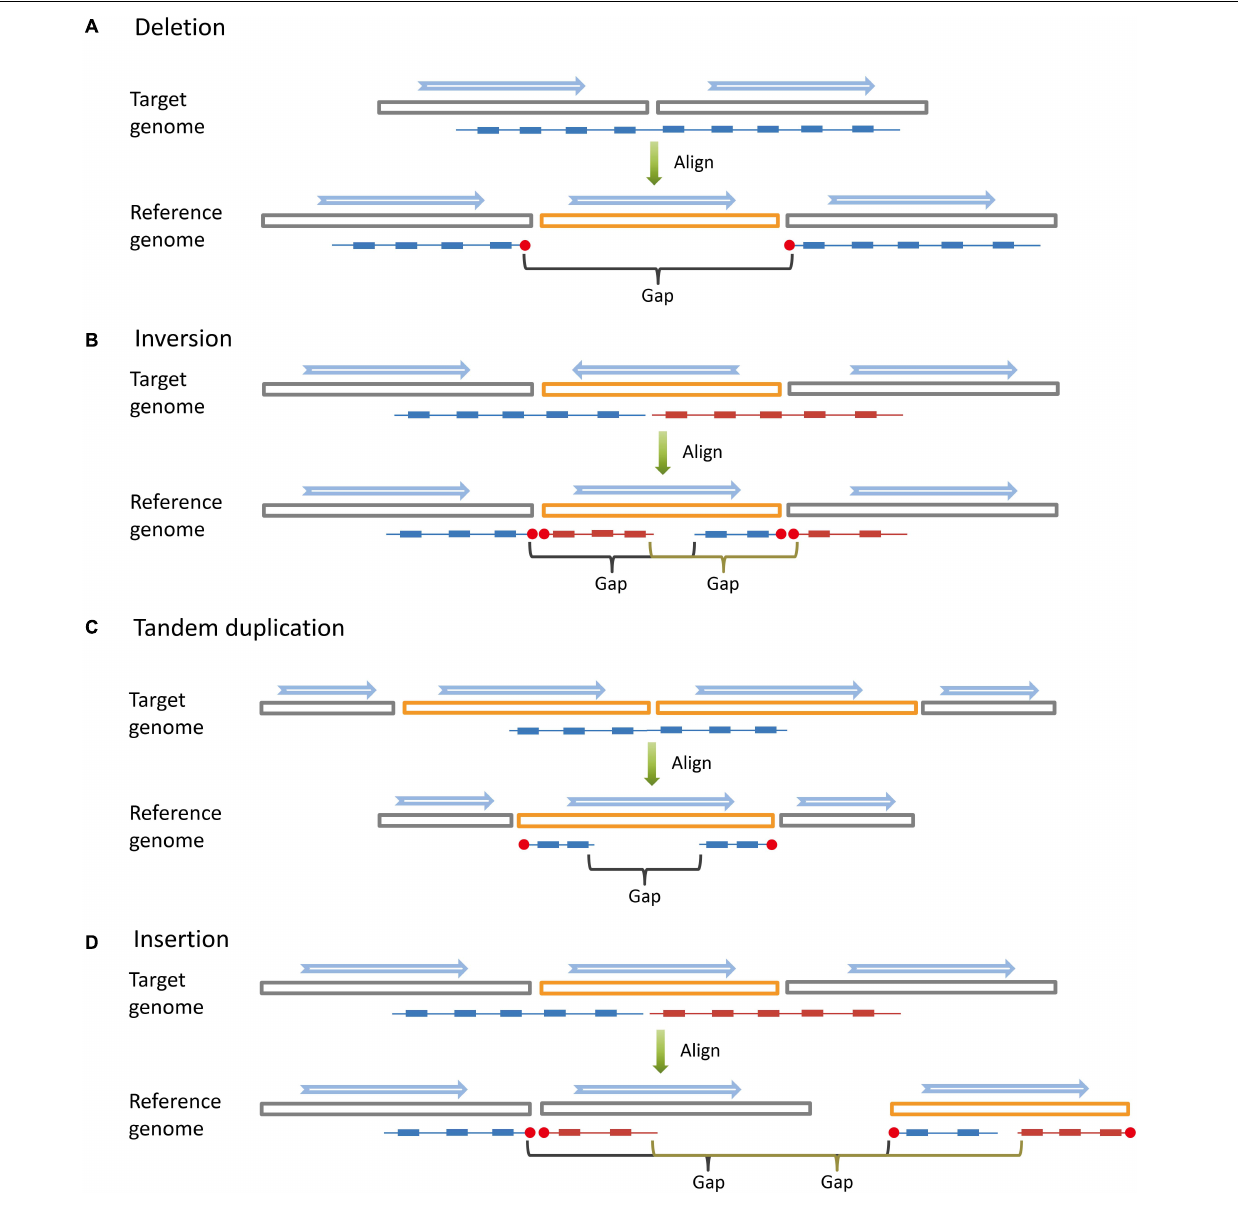
FIGURE 1 | Long DNA fragments (colored lines) are constructed by read pairs (small solid blocks) that share the same barcode. When aligned to the reference genome, long DNA fragments covering large structural variations are broken into sub-fragments by large gaps. The blue arrows indicate the directions of genome sequences (big hollow blocks). (A) Deletion. (B) Inversion. (C) Tandem duplication. (D)